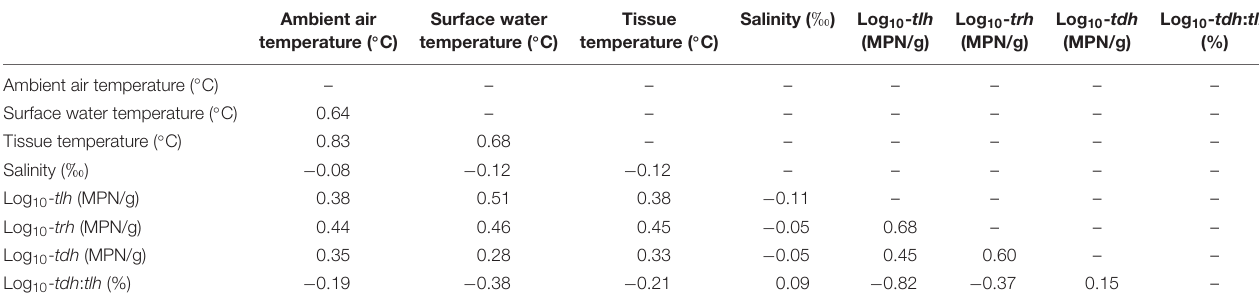
TABLE 2 | Pearson correlation matrix of all environmental and V. parahaemolyticus genetic